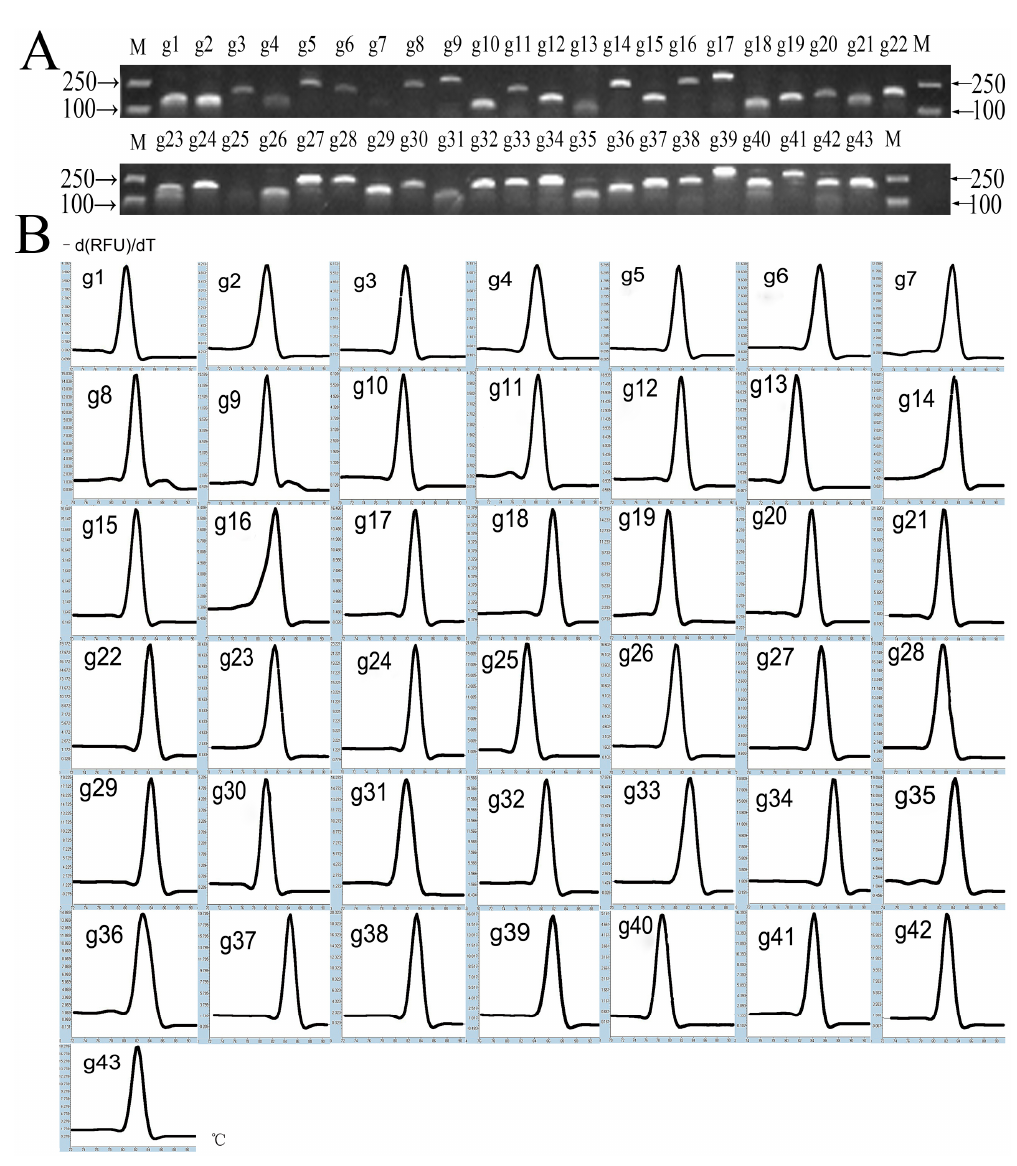
Figure 1. Specificity of primer pairs for RT-qPCR amplification. ( A ) Agarose gel (2%) showing amplification of a specific PCR product of an expected size for each candidate reference gene tested in the study. ( B ) Melting curves for the 43 candidate reference genes with single